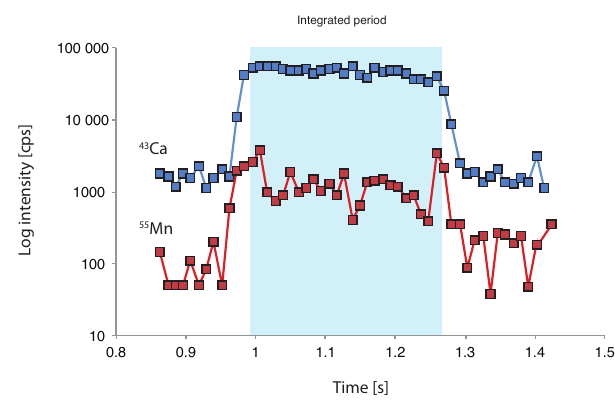
Figure 2. Example of a laser ablation profile with signal log inten- sity counts per second (cps) through time. The integrated signal is